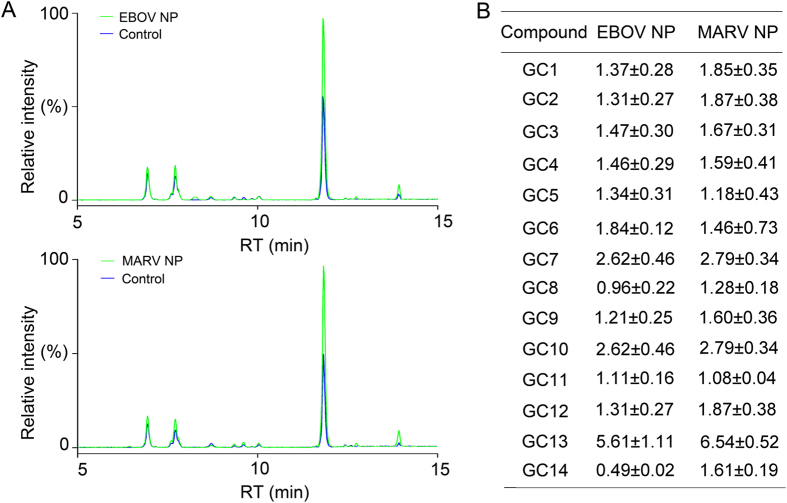
Validation of NP ligands in compound mixture screens.(A) LC-HRMS chromatograms of the protein incubation sample and the control from the EBOV NP experiment (upper) and MARV NP experiment (lower). The NP protein was incubated with a mixture of 14 pure compounds known to be licorice constituents and then ligands were identified by affinity MS analysis. (B) S/N ratios of specific compounds from the mixture screen experiment. Note that GC2/GC12 and GC7/GC10 show identical S/N ratios as they are isomeric pairs that cannot be distinguished under the LC condition. GC7/GC10 and GC13 with S/N > 2 are considered ligands to both NPs.